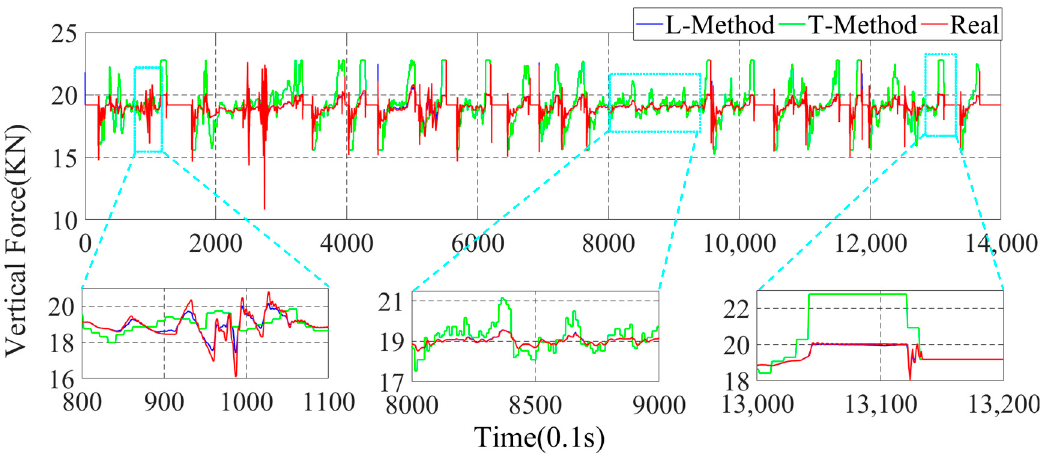
Figure 10. Parameter estimation of the left-front wheel vertical force of the vehicle.